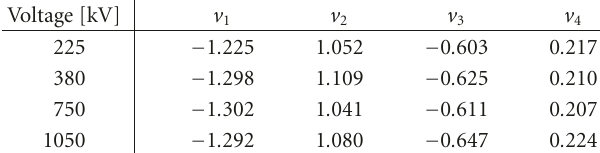
Table 1: Values of the digital filter coe ffi cients { v (cid:8) } 4 various service voltages.